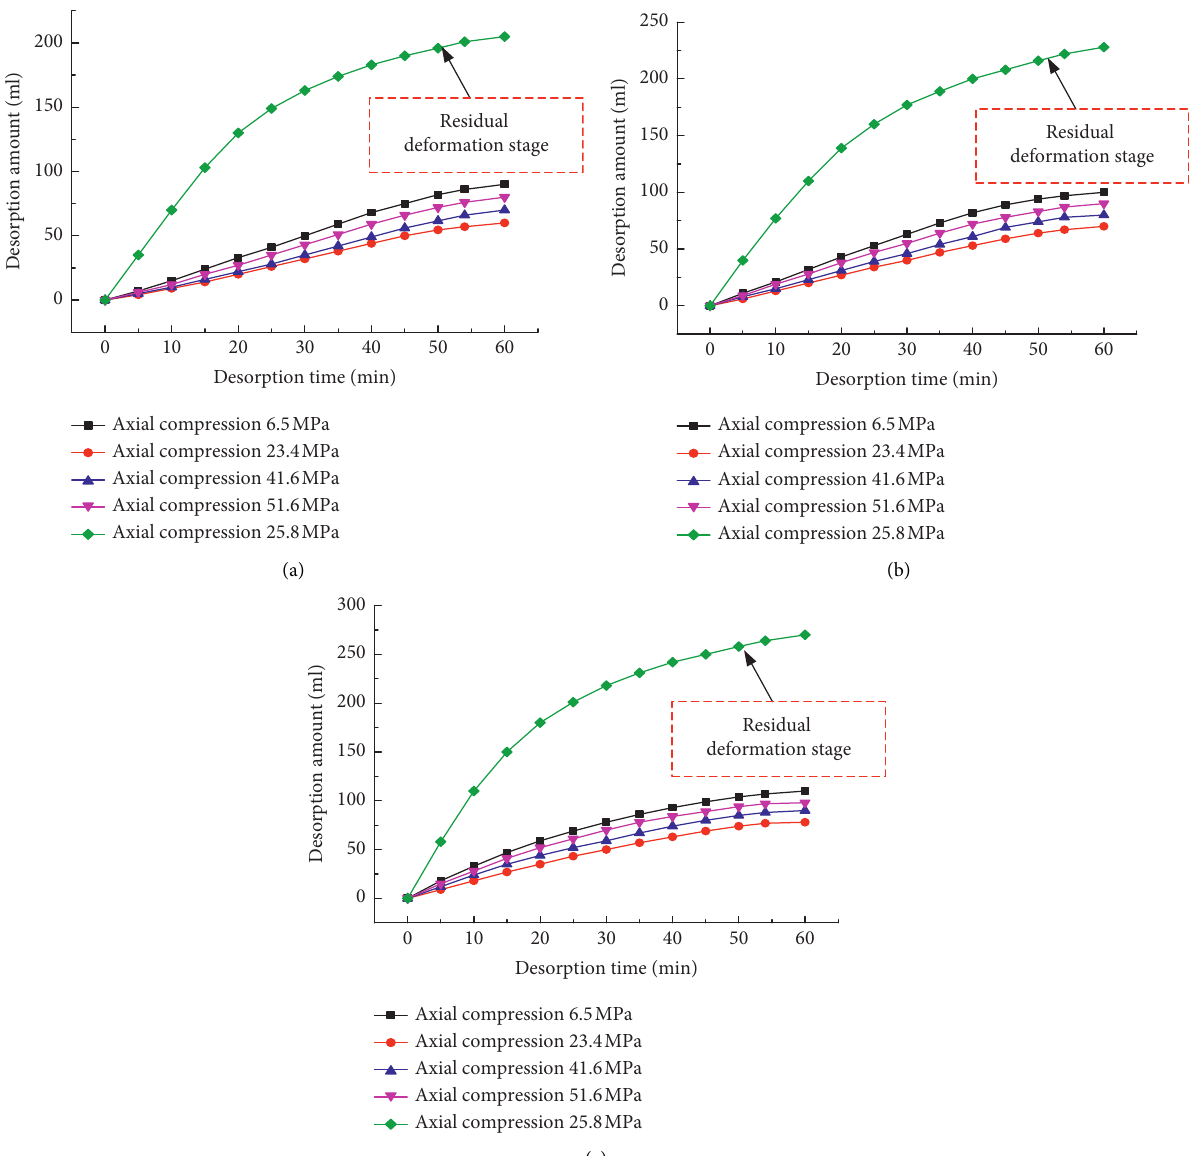
Figure 10: Desorption amount curve under the confining pressure of 5 MPa at the temperature of (a) 30 ° C, (b) 45 ° C, and (c) 60 °